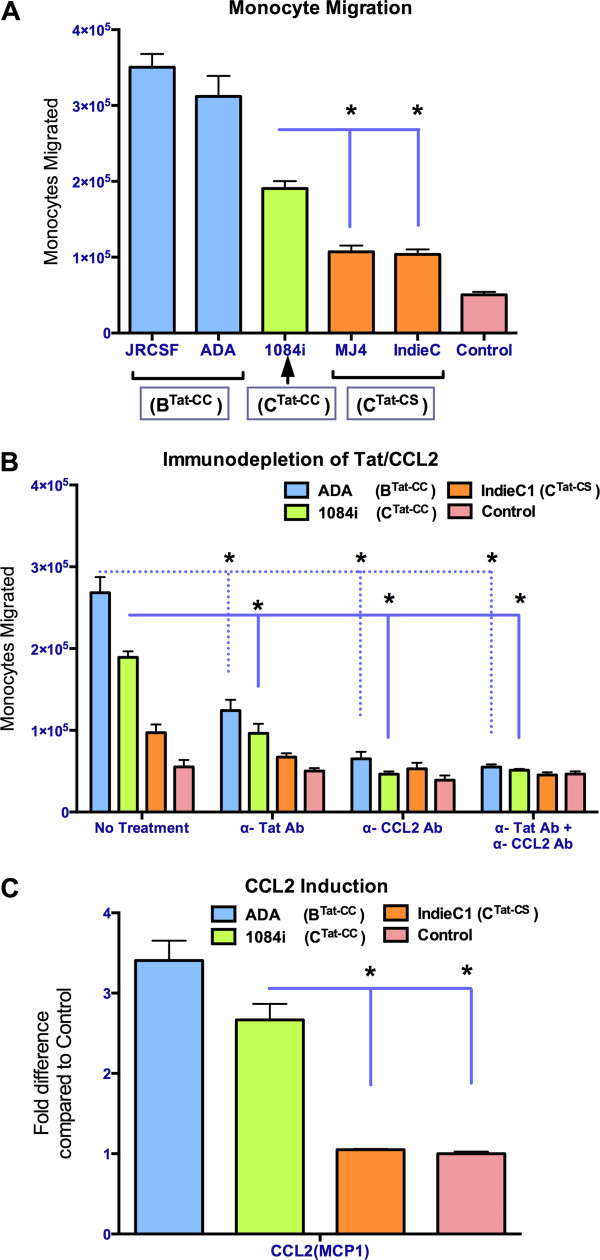
Differential monocyte recruitment by medium from macrophages infected with different HIV-1 isolates. A. Monocyte migration caused by medium from HIV-1 infected MDMs. At least two isolate are used for each clade. HIV-1B isolates are shown in blue, HIV-1C isolates in orange and HIV-1C1084i in green. Southern African HIV-1C1084i with a dicysteine motif in Tat induces significantly higher number of monocytes to migrate compared to HIV-1C IndieC1 and HIV − 1CMJ4. Tat genotypes of each isolate are indicated in all three panels. B. Determining the soluble factors in the infected MDM supernatant responsible for monocyte migration. Immuno-depletion of Tat and CCL2 resulted in significant (*) reduction of monocyte recruitment both by HIV-1ADA (Clade B with dicysteine motif in Tat) and HIV-11084i (Clade C with dicysteine motif in Tat) infected supernatants. Serial immuno-depletion of both CCL2 and Tat did not further reduce background migration. C. Fold increases, over uninfected macrophages, in the level of CCL2 secreted by macrophages infected with various HIV-1 isolates: HIV-1BADA, HIV-1C1084i and HIV-1CIndieC1. The levels of these chemokines in the media from uninfected control MDM cells were CCL2: 20.8ng/ml. HIV-1C1084i induced significantly higher levels of CCL2 induction compared to HIV-1CIndieC1 and Controls. * p < 0.05.